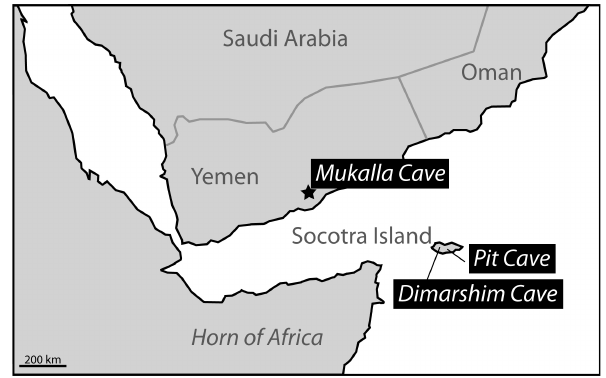
Fig. 1. Overview map showing Yemen with Socotra Island and the locations of Mukalla Cave, Dimarshim Cave, and Pit